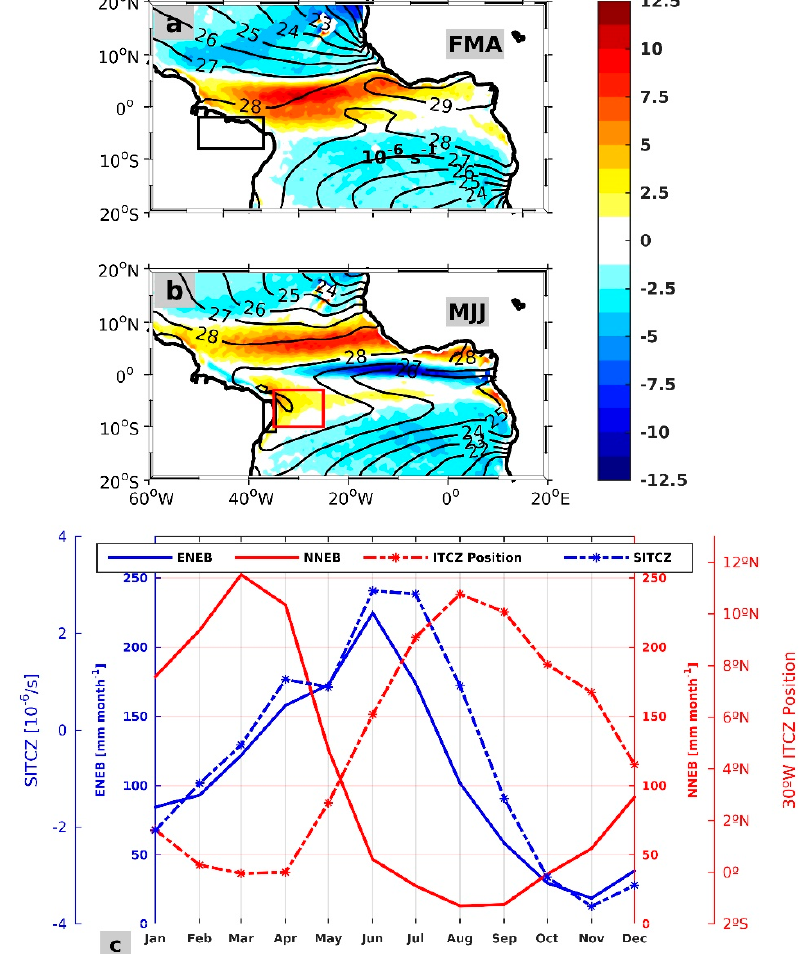
Figure 1. Climatologies (2000–2015) of surface wind convergence (from Quick Scatterometer (QuikSCAT) and Advanced Scatterometer (ASCAT) , 10 − 6 s − 1 , shaded) and sea surface temperature (SST; from Objectively Analyzed Air-Sea Fluxes Project- OAFlux, °C, contour) in ( a ) February-to-April (FMA) and ( b ) May-to-July (MJJ), which respectively, correspond to the Northern Northeast Brazil (Northern NEB; black box in ( a )) and Eastern Northeast Brazil (Eastern NEB; black box in ( b )) rainy seasons. The oceanic red box in ( b ) corresponds to the region used to define the southern intertropical convergence zone (SITCZ) index. ( c ) Climatological evolution of Northern NEB (red line; 2°–8° S; 37°–50° W) and Eastern NEB (blue line; 5°–11° S; 34.5°–37° W) rainfall (from Global Precipitation Climatology Centre (GPCC), mm month − 1 ); ITCZ position at 30° W (2° S–12° N; red dotted line) and SITCZ index (10 − 6 s − 1 ; blue dotted line; 3°–10° S; 25°–35° W) for the period of 2000-2015. ITCZ position and SITCZ have been estimated using the high horizontal resolution (0.25 °) QuikSCAT and ASCAT winds data.